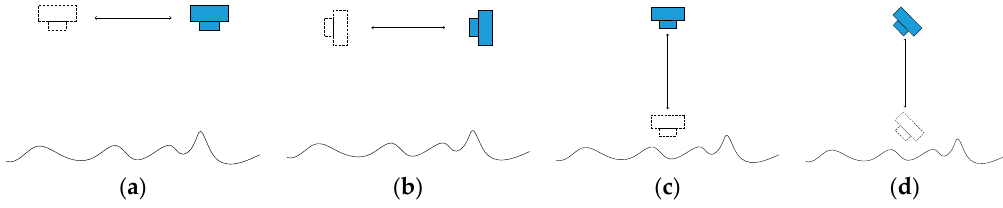
Figure 1. Image acquisition trajectories of monitoring cameras. ( a ) Translational motion, camera downward viewing; ( b ) Translation motion, camera tilt; ( c ) Vertical motion, camera downward viewing; ( d ) Vertical motion, camera tilt.